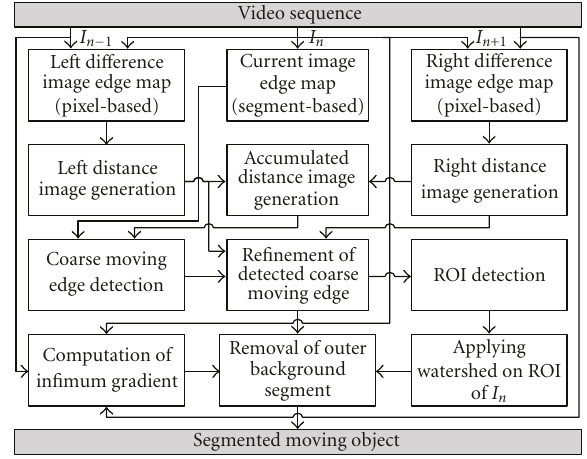
Figure 2: Flow diagram of the proposed